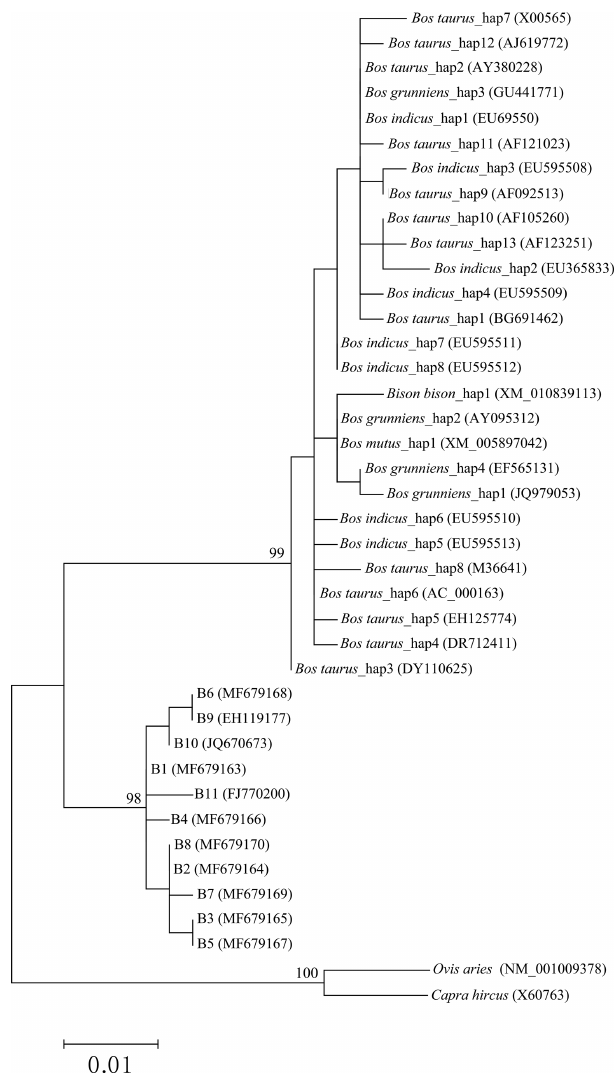
Figure 5. Phylogenetic trees constructed by using the maximum- likelihood method (Hasegawa–Kishino–Yano model). Bootstrap values are based on 10000 replicates and are adjacent to